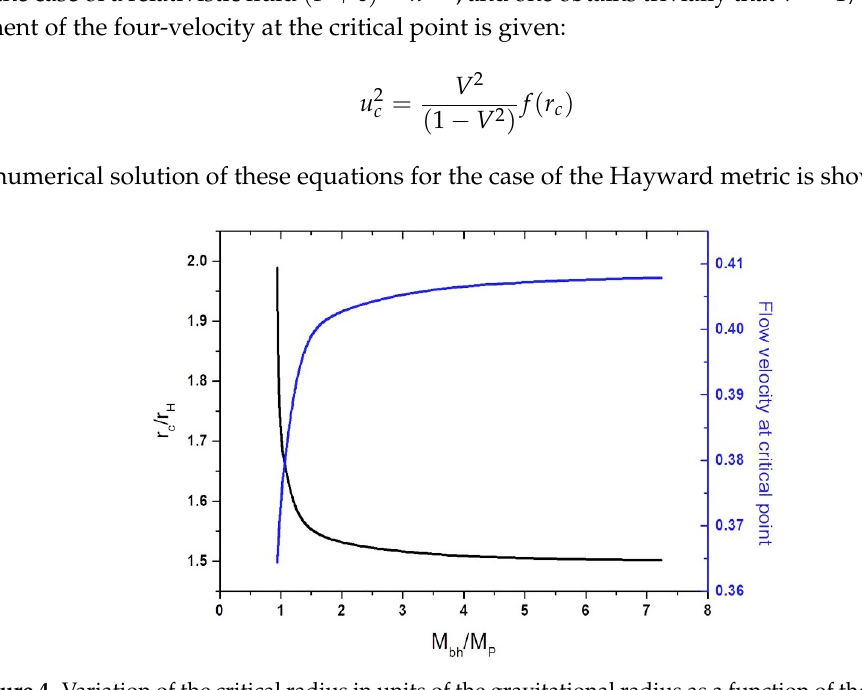
Figure 4. Variation of the critical radius in units of the gravitational radius as a function of the Hayward black hole mass in units of the Planck mass (black curve). The radial component of the four-velocity of the flow is also shown as a function of the black hole mass (blue curve).